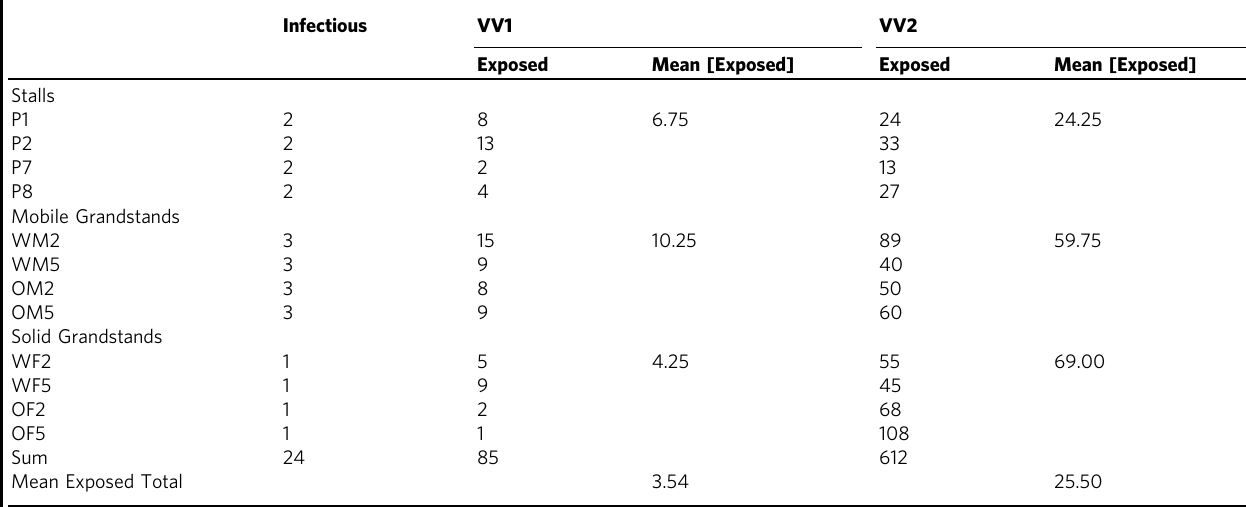
Table 1 Differences in overall and mean exposure to infectious aerosols in ventilation version 1 (VV1) and ventilation version 2 (VV2) for Sscenario